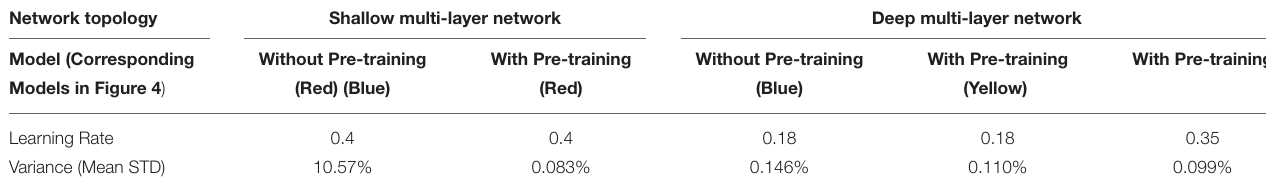
TABLE 2 | Learning rate and mean standard deviation of classification errors in shallow and deep multi-layer networks. Network